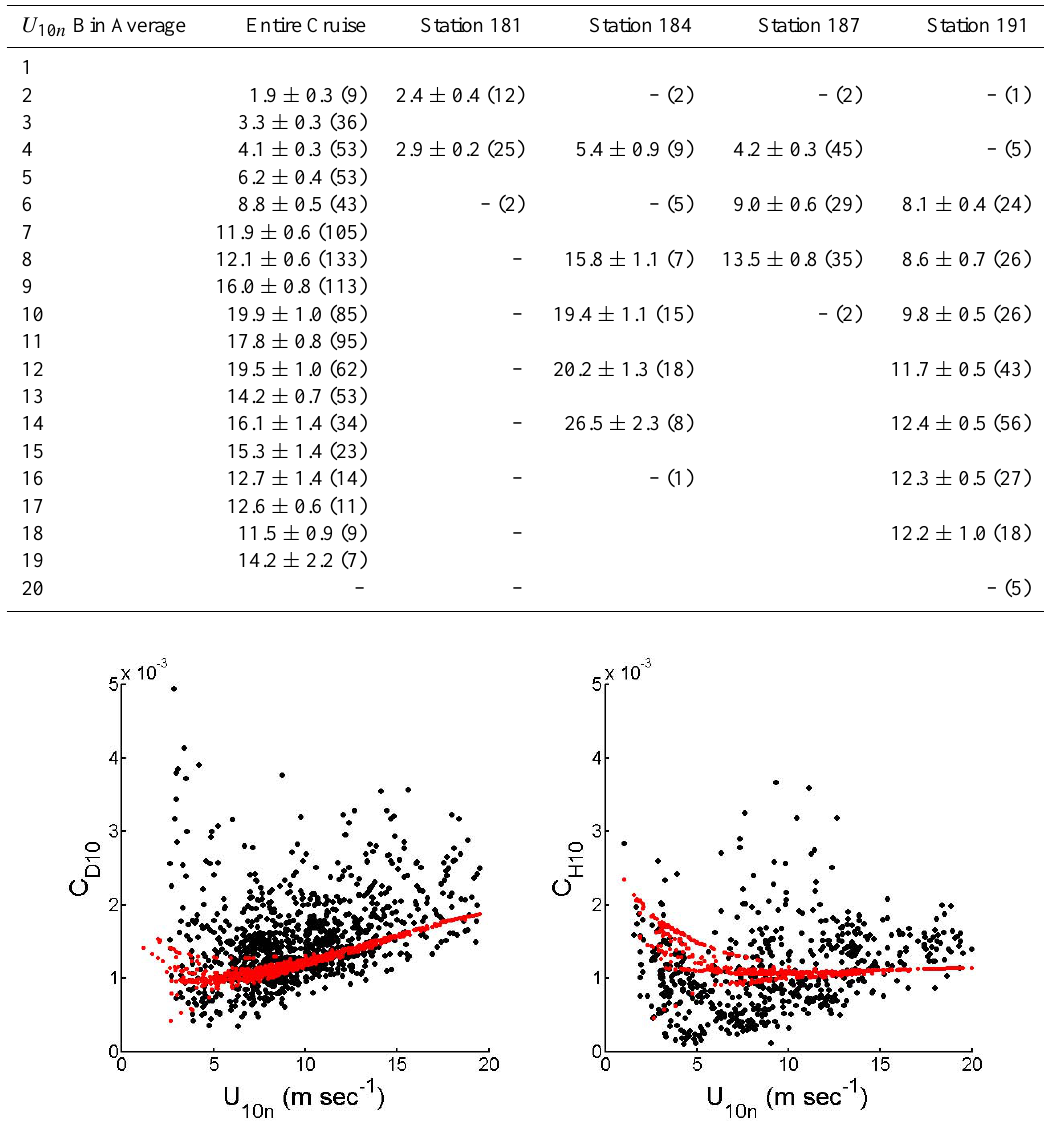
Fig. 5. Momentum (left) and sensible heat (right) transfer coefficients during Knorr_11. Black: eddy covariance measurements for 10 min intervals. Red: transfer coefficients calculated using the NOAA COARE model (Fairall et al., 2003) for the environmental conditions en- countered during